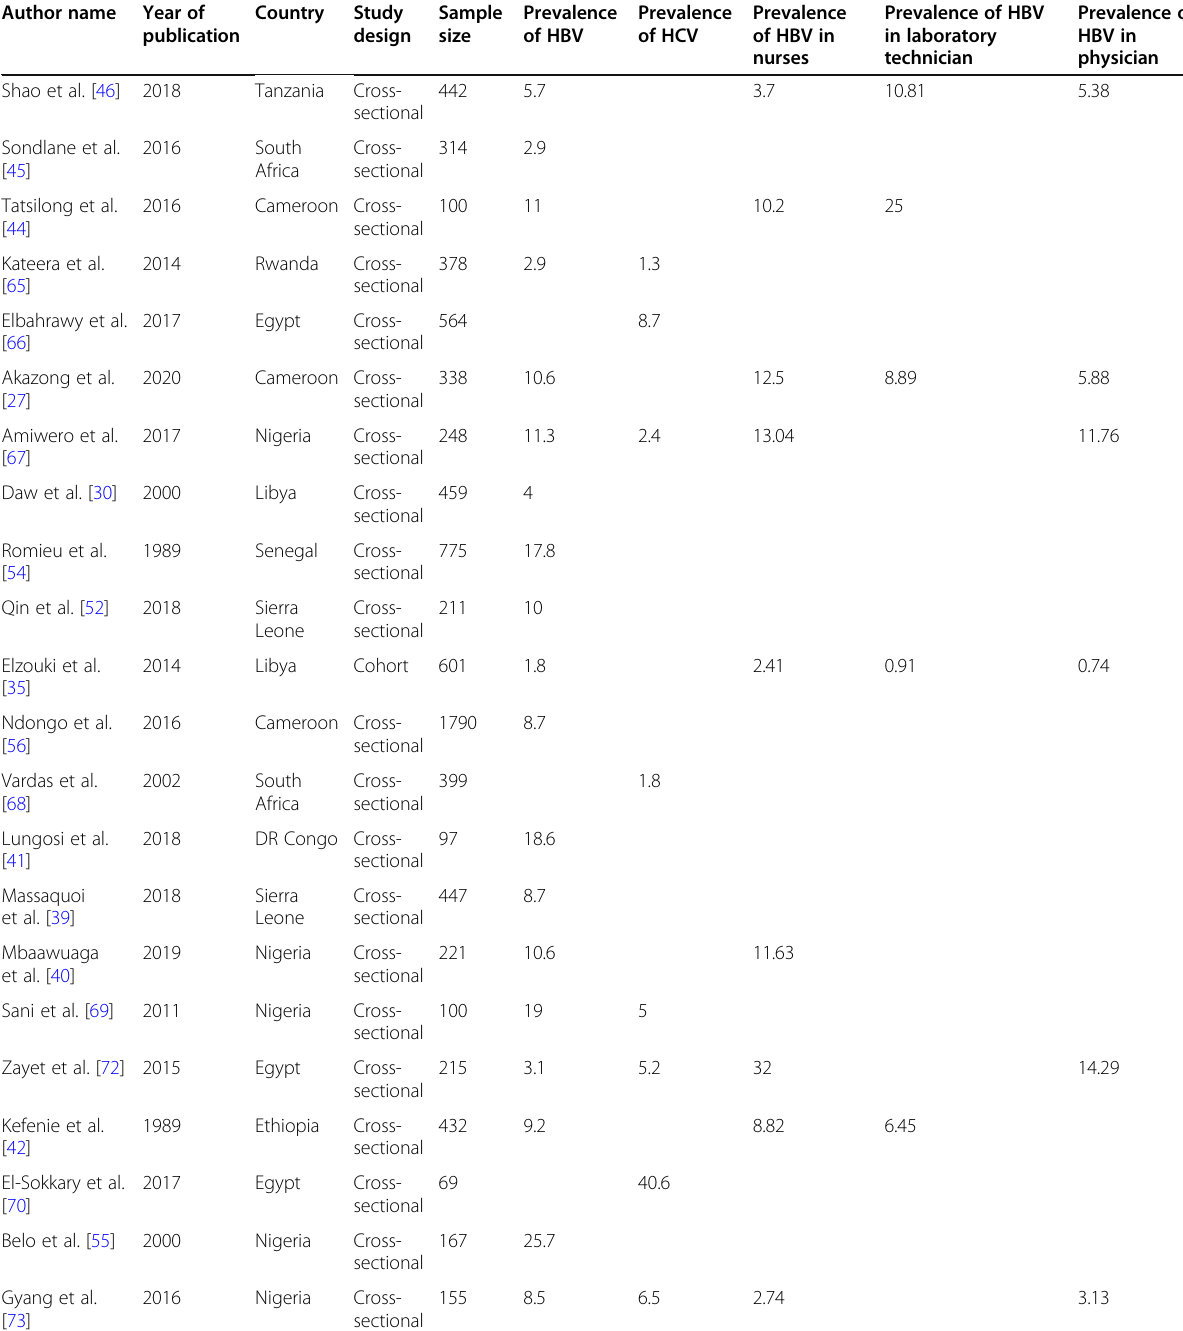
Table 1 Characteristics of included studies in meta-analysis on prevalence of hepatitis B and C in Africa